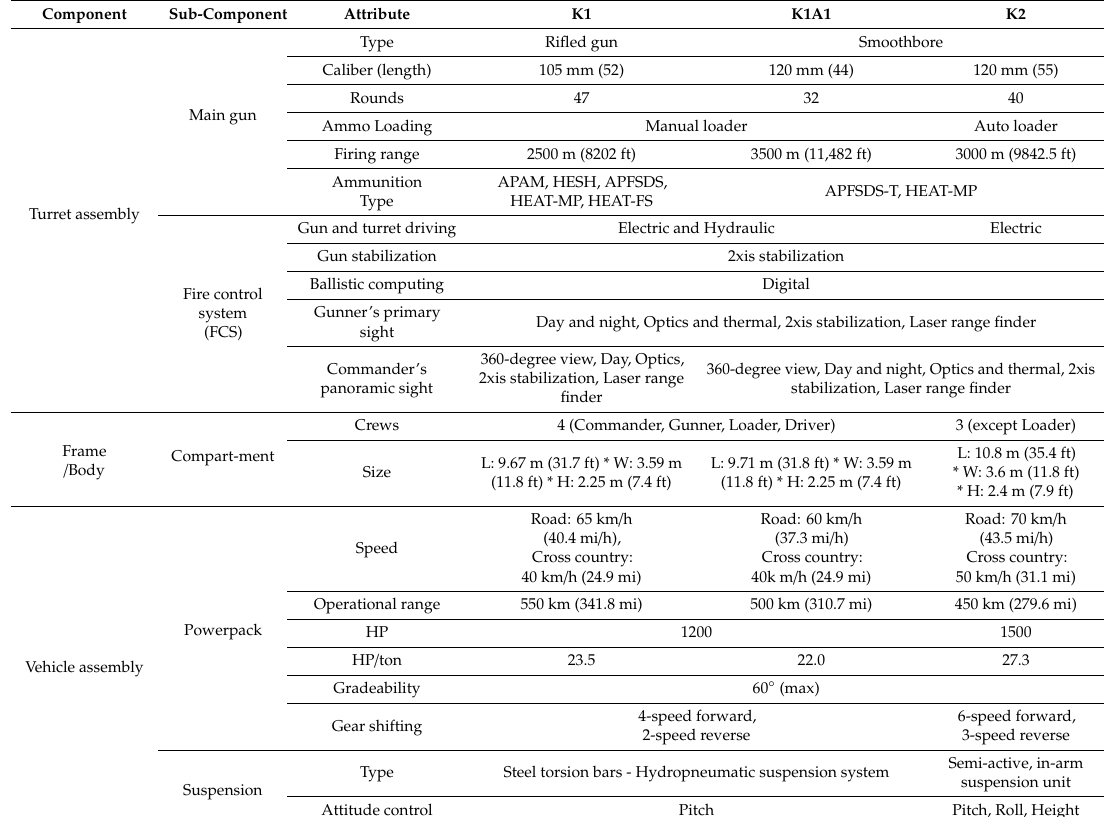
Table A3. Specifications of K-series main battle tanks